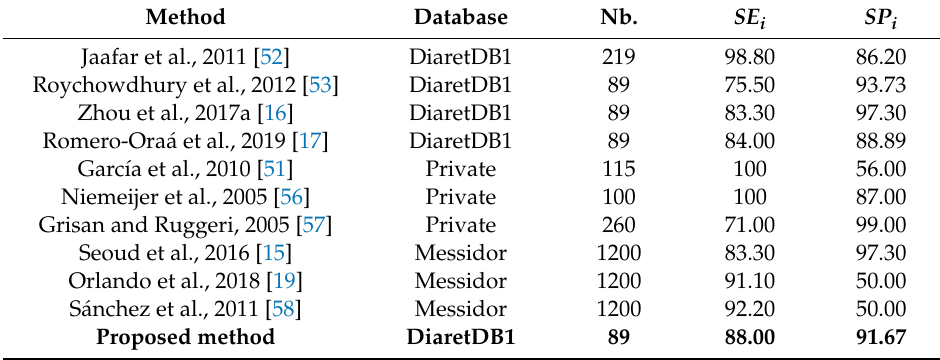
Table 4. Comparison of some methods for red lesion detection.